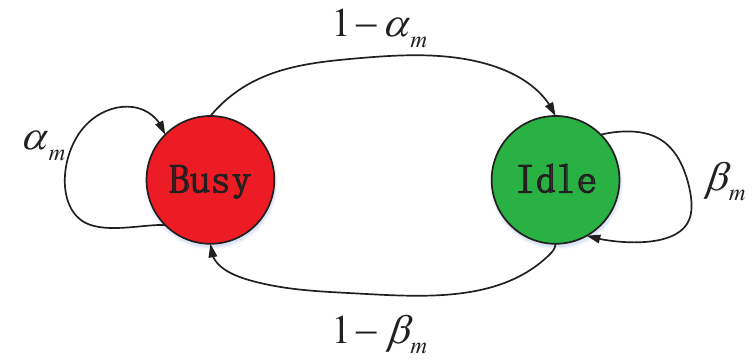
Figure 2. Occupancy state transition diagram of PU channel m